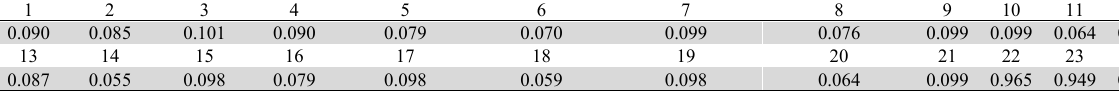
Wind generation of peer 14 (MWh). All test cases 1